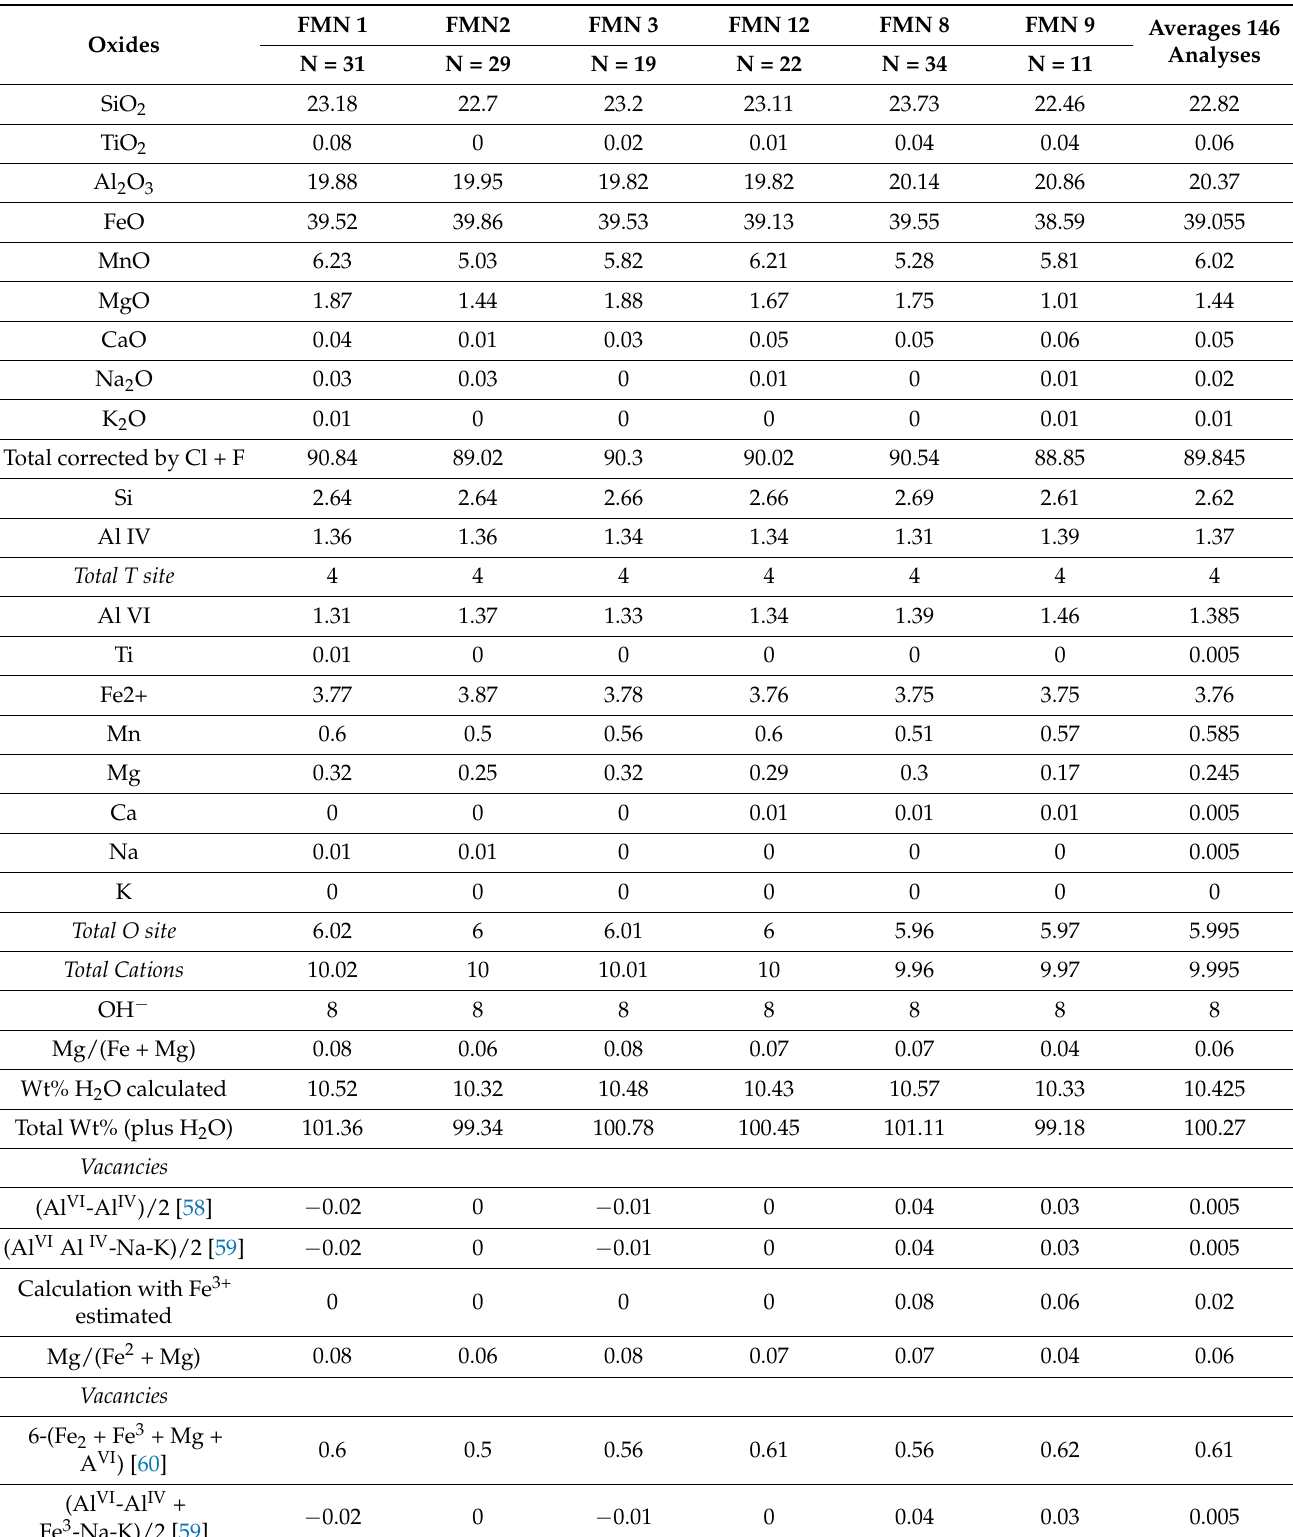
Table 2. Electron microprobe data of Fe,Mn-chlorite and calculus of structural formula based on 14 oxygens (Fe 2+ /Fe 3+ and OH calculated assuming full site